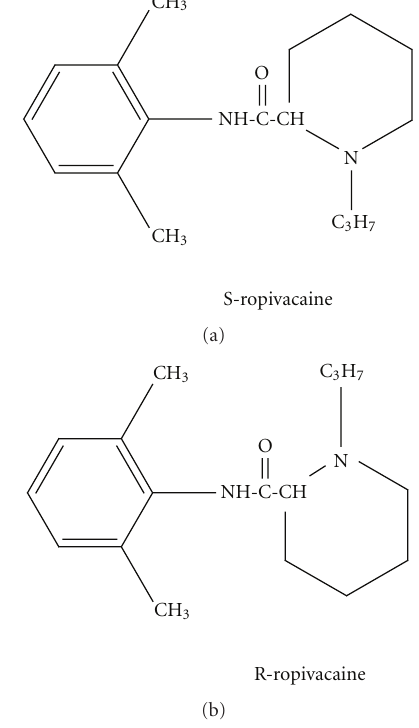
Figure 5: Structure of S and R enantiomers of ropivacaine (marketed as the S